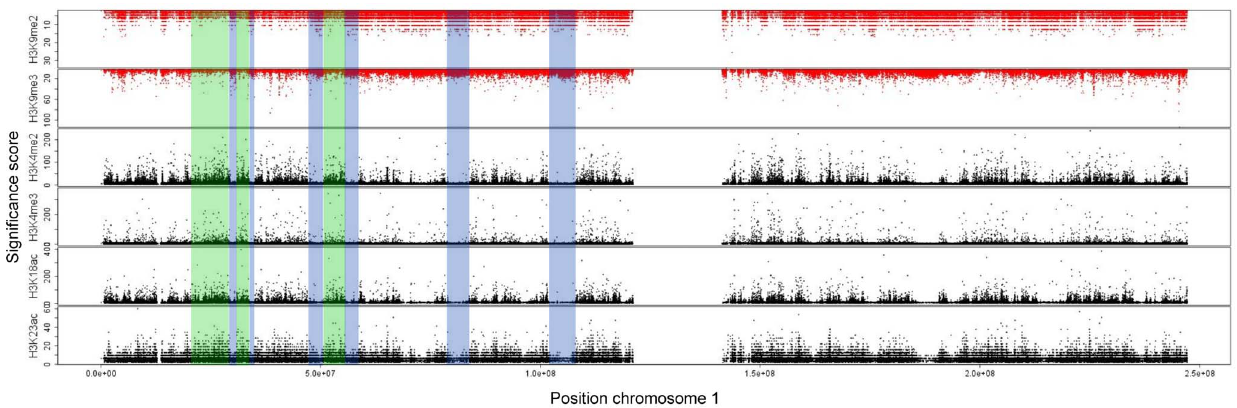
Figure 1. Heterochromatic and euchromatic histone modifications form non-overlapping domains on a coarse scale. We used the measurements obtained in a genome-wide experiment on human CD4 + T cells from [59] and [57] and analyzed them using the CCAT (version 3.0) tool [73]. We adapt the analysis using slightly less stringent parameters than the default ones allowing for noisy measurements with lower significance in order to obtain a most complete modification landscape. The plot exhibits the significance scores of the histone modifications H3K9me2 and H3K9me3 related to heterochromatin (red) and H3K4me2, H3K4me3, H3K18ac and H3K23ac related to euchromatin (black). We visualized the distribution over entire chromosome 1. Heterochromatin marks were plotted upside down for better visualization. Both sets of modifications form very similar patterns and form regions of higher and lower abundance. We marked some of the regions with high (low) euchromatic and low (high) heterochromatic content green (blue).